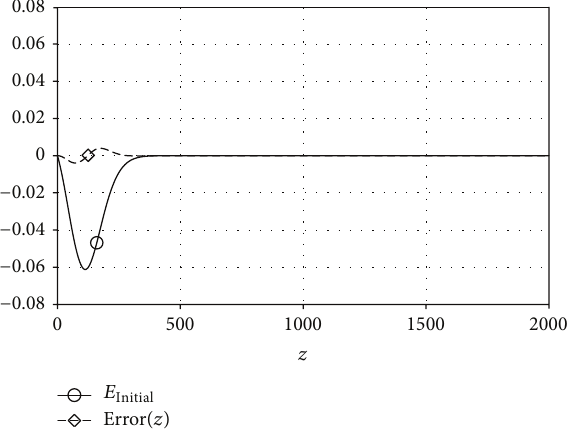
Figure5:Comparisonofrelativeerrorsfortheinitialapproximation and approximate analytic solution of BVP (19), (20).